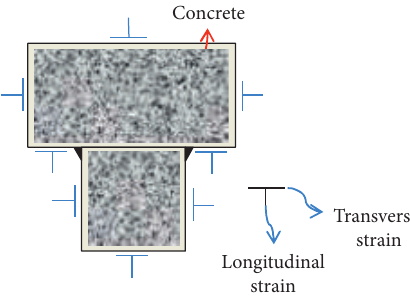
Figure 8: Schematic layout of strain gauges.